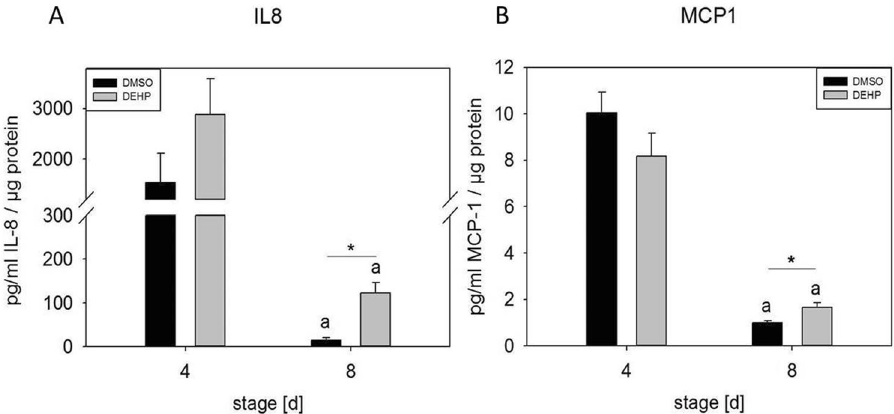
Figure 1. IL8 and MCP1 ELISA with supernatants from SGBS-derived cells. SGBS-derived cells were exposed to DEHP [50 µg/ml] from d0–d4 of adipogenesis. Samples of the cell supernatant were taken at d4 and d8 of differentiation. IL8 and MCP1 ELISA was performed. The data were statistically analyzed by one-way ANOVA on ranks with the Student–Newman–Keuls method. N = 7, n = 1 (4 pooled wells); *p ≤ 0.05 DEHP vs. DMSO at d4 or d8; a p ≤ 0.05 DMSO d4 vs. DMSO d8, DEHP d4 vs. DEHP